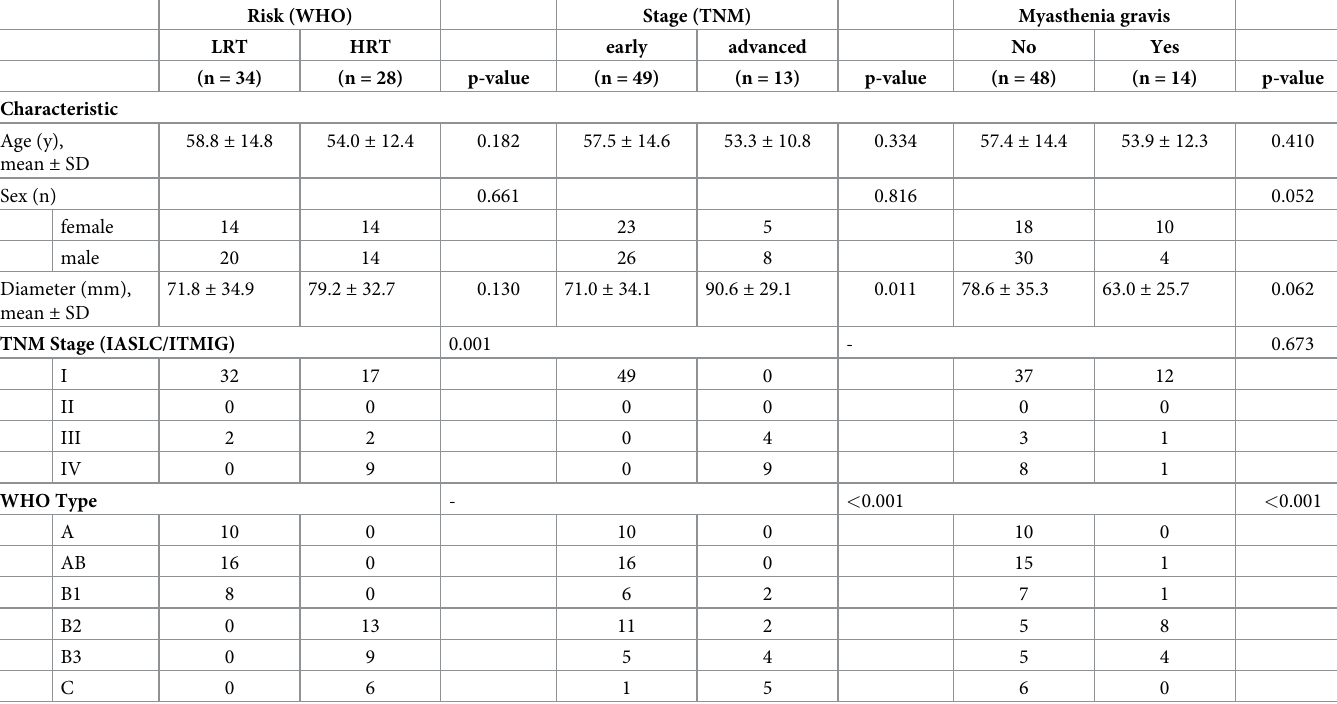
Table 1. Patient characteristics.